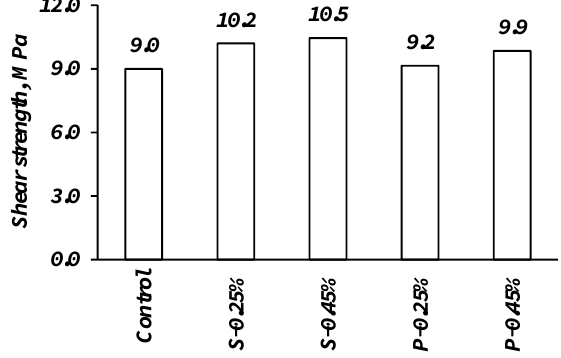
Figure 8. Effect of fibers on the shear strength.